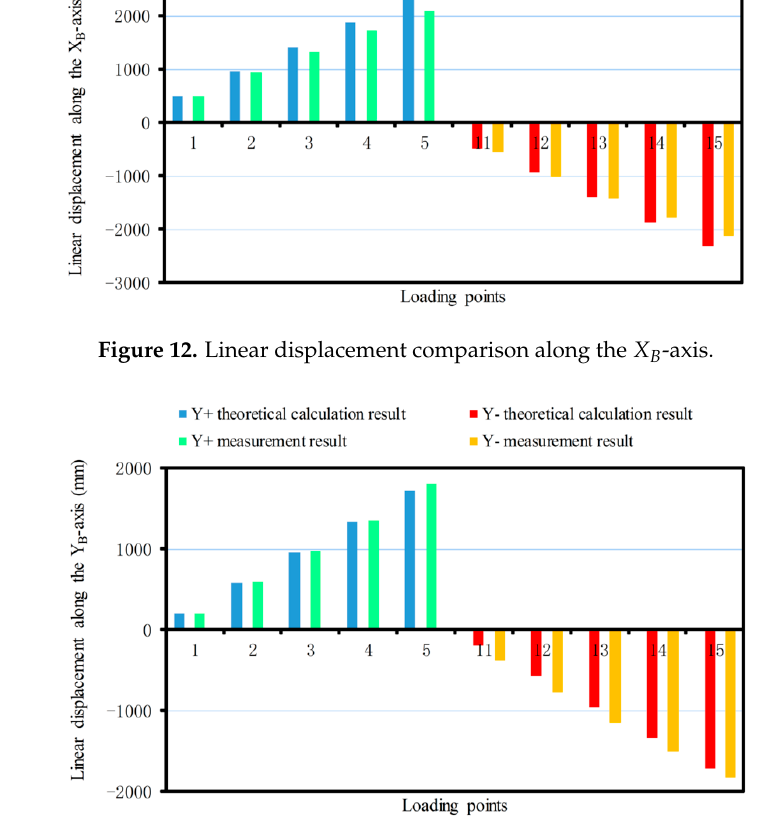
Figure 13. Linear displacement comparison along the Y B -axis.